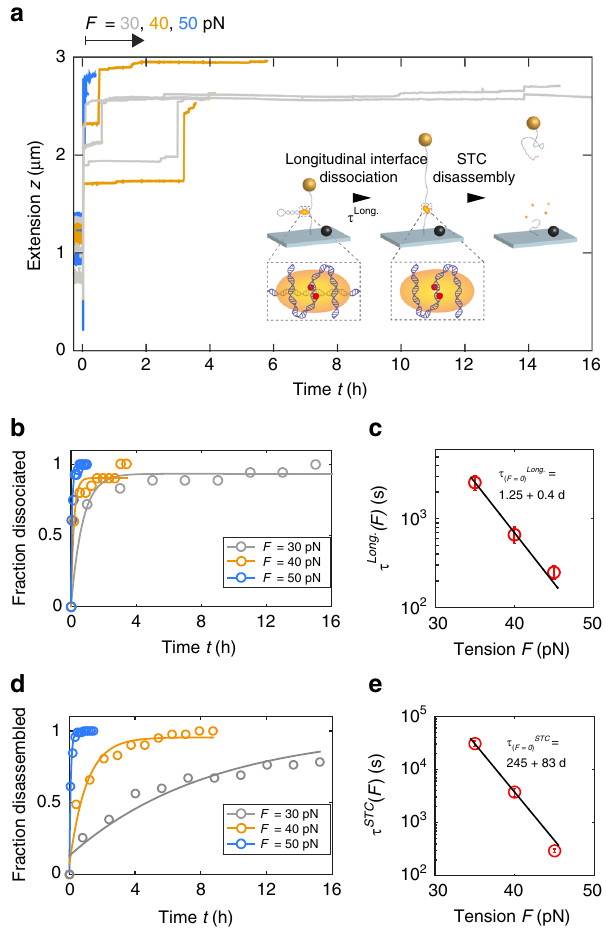
Fig. 5 Forced disassembly of STCs. a Typical extension time traces of reacted tethers subjected to high tension (30, 40, 50 pN) depicting large extension jumps preceding bead release ( n 30pN = 55; n 40pN = 41; n 50pN = 36). b Cumulative distributions of dissociated longitudinal interfaces over time for forces 30, 40, 50 pN, and exponential fi ts to the data yielding lifetimes τ Long ( F ). c Dependence of lifetime τ Long . on tension F and fi t to the Bell model ( τ (F = 0) Long . = 1.25 ± 0. d Δ x Long . = 5.1 ± 0.5 Å; errors are standard fi t error). d Cumulative distributions of disassembled STCs over time for forces 30, 40, 50 pN and exponential fi ts to the data yielding lifetimes τ